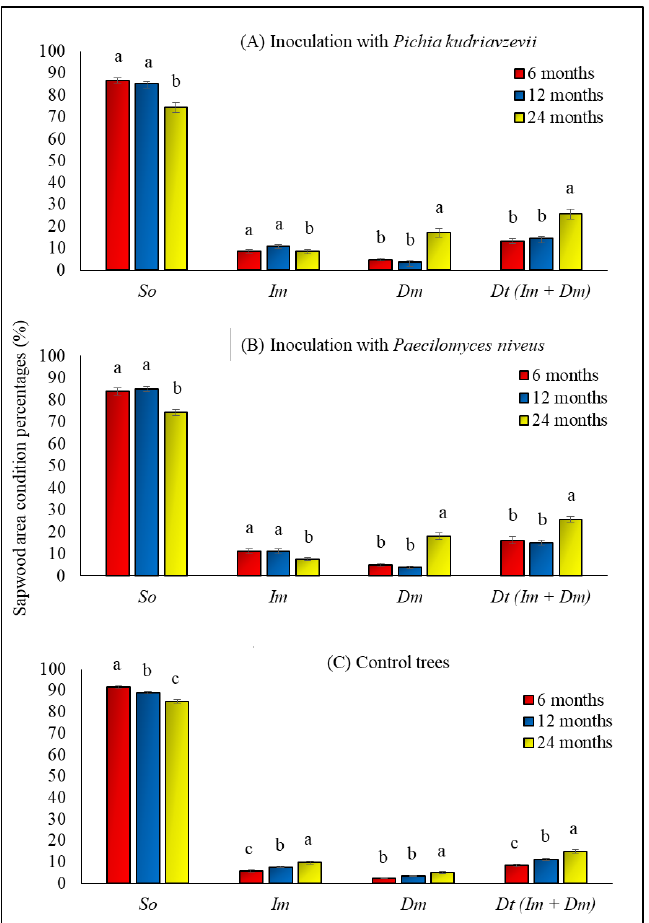
Figure 6. Effect of inoculation types measured through non-invasive SoT that converted velocity to a So % and Dt % in the sapwood area of A. malaccensis trees. ( A ) = significant differences ( p ≤ 0.05) in So % and Dt % in the trees inoculated with P. kudriavzevii in the measured months, ( B ) = significant differences ( p ≤ 0.05) in So % and Dt % in the trees inoculated with P. niveus in the measured months, ( C ) = significant differences ( p ≤ 0.05) in So % and Dt % in control trees at the measured months. Note: So = solid zone, Im = intermediate zone, Dm = damage zone, Dt = deteriorated wood, and small capital letters show significant differences between months. The error bar represents the mean standard error ( n = 27); distinct letters imply significant distinctions between inoculation duration following Duncan’s multiple comparison test ( p < 0.05).